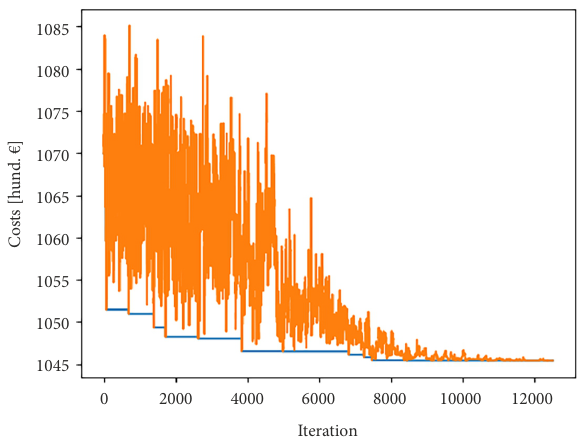
Figure 3. Typical run of the SA algorithm in the case study. The best solution obtained currently indicated in